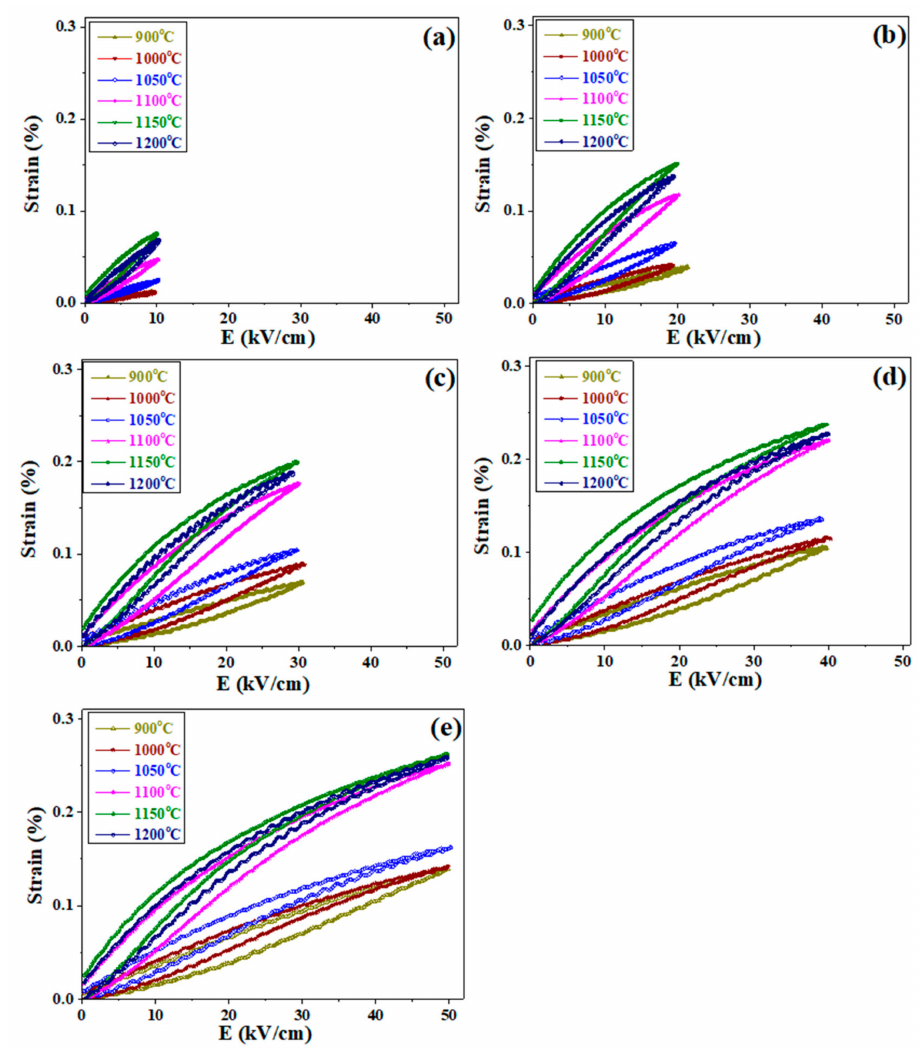
Figure 6. Unipolar S-E hysteresis curves measured at ( a ) 10 kV / cm, ( b ) 20 kV / cm, ( c ) 30 kV / cm, ( d ) 40 kV / cm and ( e ) 50 kV / cm, respectively, for the microwave-sintered PLZT 8 / 60 / 40 ceramics, 1 Hz and 25 ◦